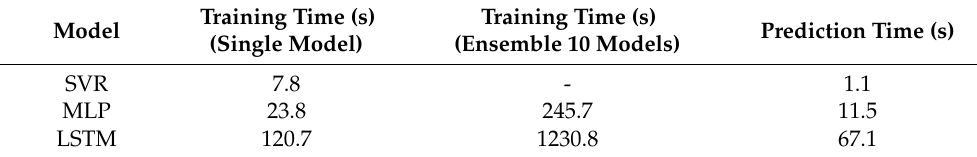
Table 5. Average computational times (expressed in seconds) for training and prediction.